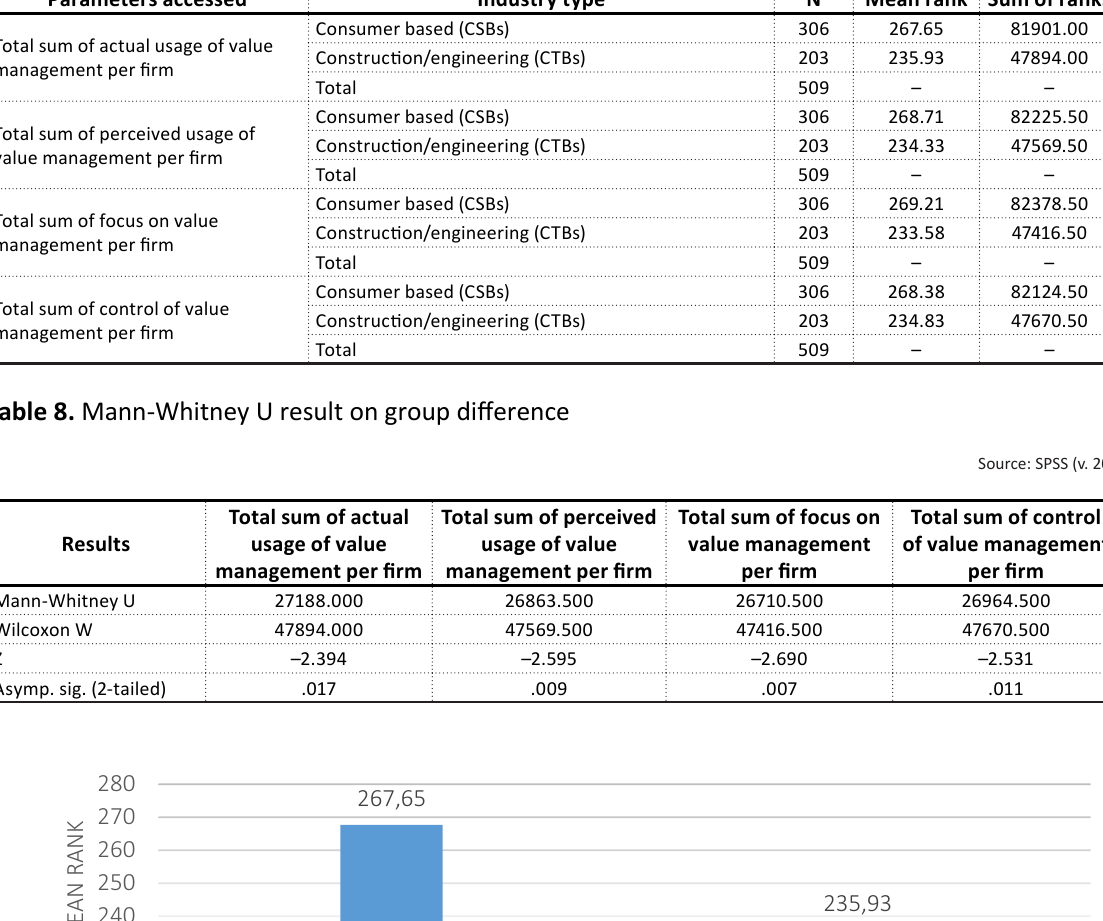
Table 7. Mean rank of value management practices per firm industrial type